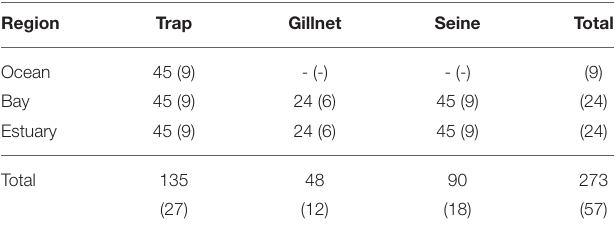
TABLE 1 | The total number of samples taken from each region by trap, gillnet, and seine net during each sampling season (“summer” and “winter”) between January 2008 and September 2010.